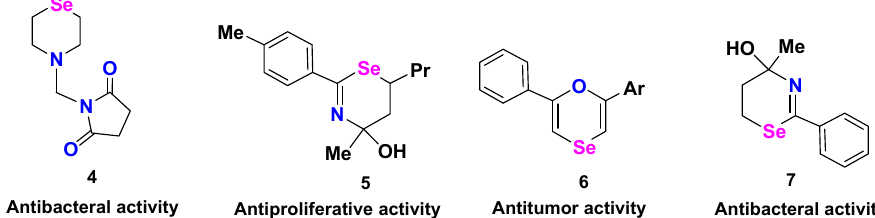
Figure 1. Examples of six ‐ membered selenium heterocycles of practical importance: 2 ‐ (4 ‐ chlorophenyl) ‐ 6 ‐ phenyl ‐ 2,3 ‐ dihydro ‐ 1,4 ‐ oxaselenine ‐ 1,4 ‐ dione ( 1 ), 7 ‐ (4 ‐ methyl ‐ 6 ‐ oxo ‐ 1,4,5,6 ‐ tetrahydro ‐ 3 ‐ pyridazinyl) ‐ 2 H ‐ 1,4 ‐ benzoselenazin ‐ 3(4 H ) ‐ one ( 2 ), qui ‐ no[2’,3’:5,6][1,4]thiaselenino[3,2 ‐ b